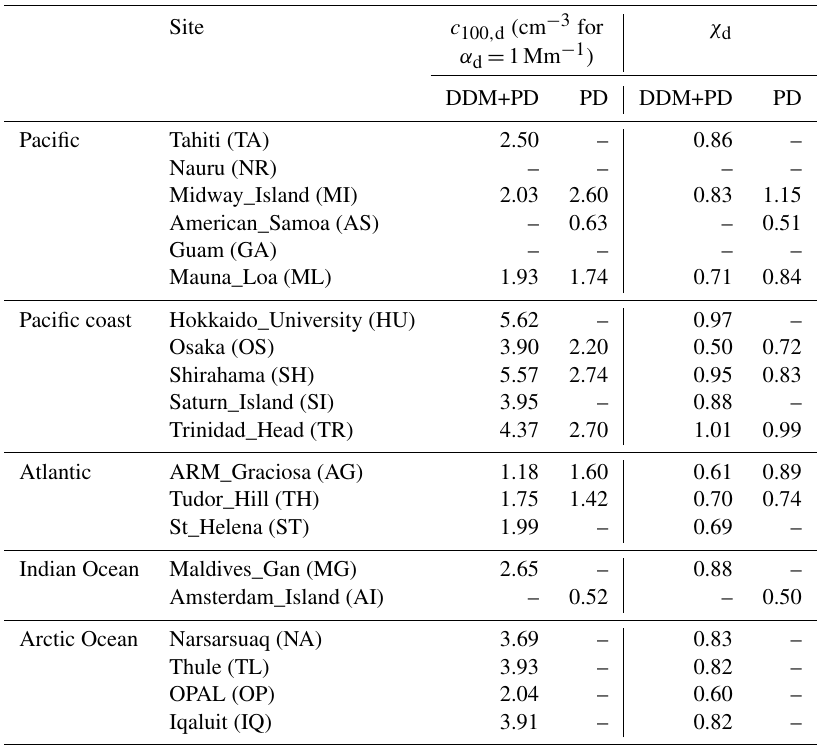
Table 5. POLIPHON dust-related conversion factors c 100 , d (in cm − 3 for α d = 1Mm − 1 ) and χ d for the dust-dominated mixture (DDM) plus pure dust (PD) and only PD based on the AERONET data analysis. The sites are classified into five clusters, including the Pacific, Pacific coast, Atlantic, Indian Ocean, and Arctic